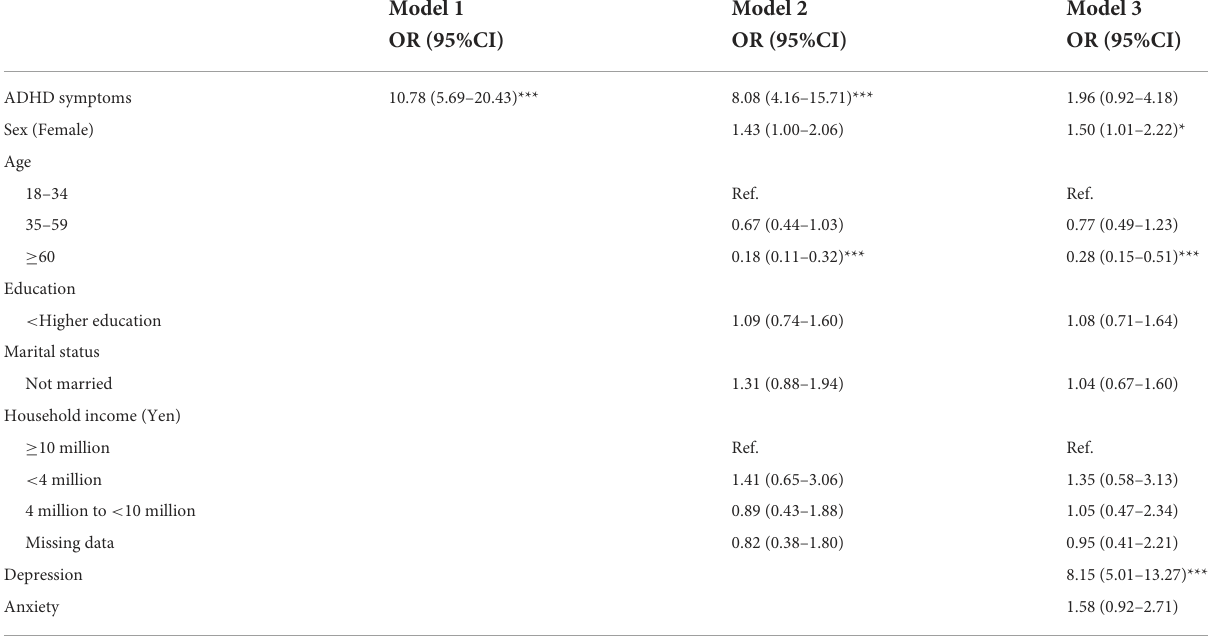
TABLE 3 Association between ADHD symptoms and suicidal ideation in Japan during the COVID-19 pandemic ( N =